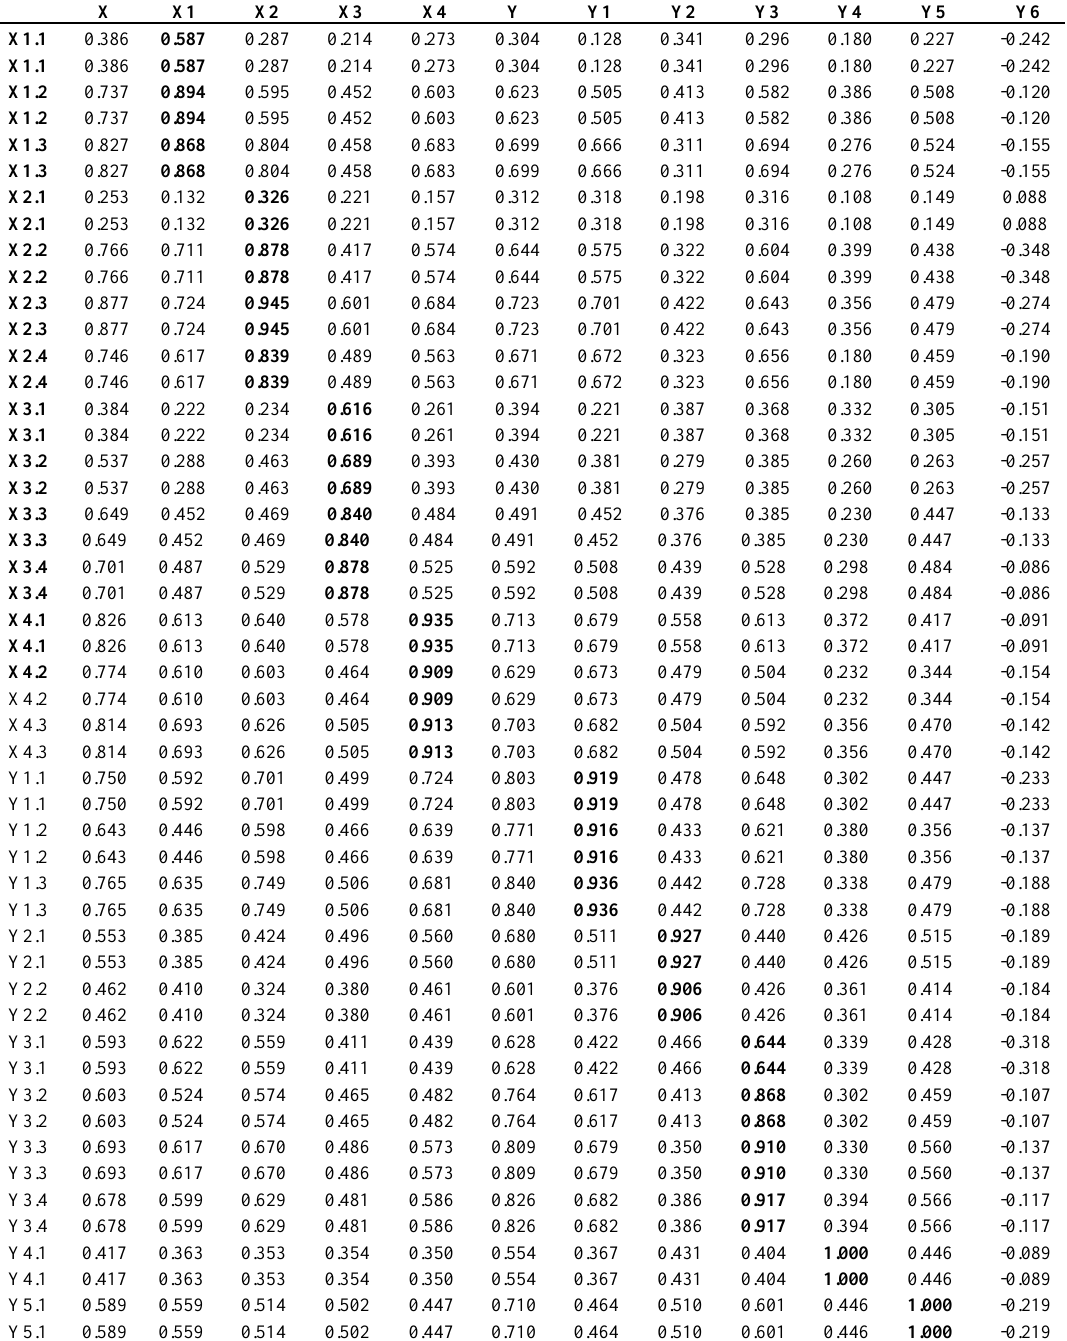
Table 4 Discriminant Validity